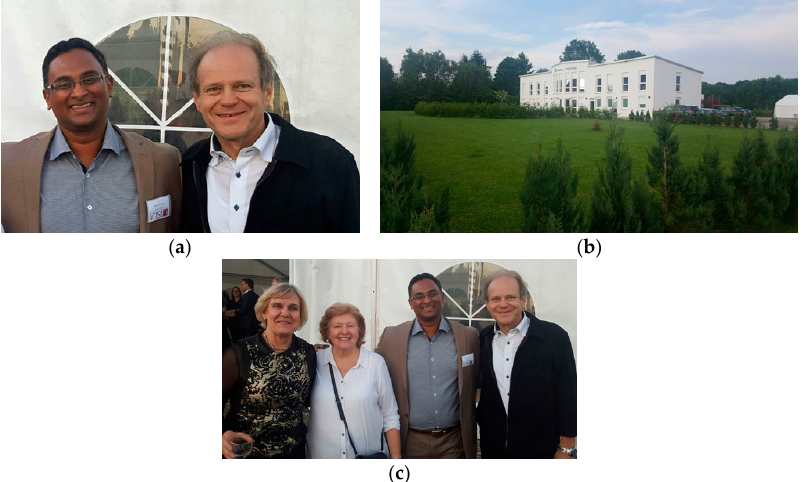
Figure 14. President elect of WALT, Professor P.R. Arany, University at Buffalo, New York and